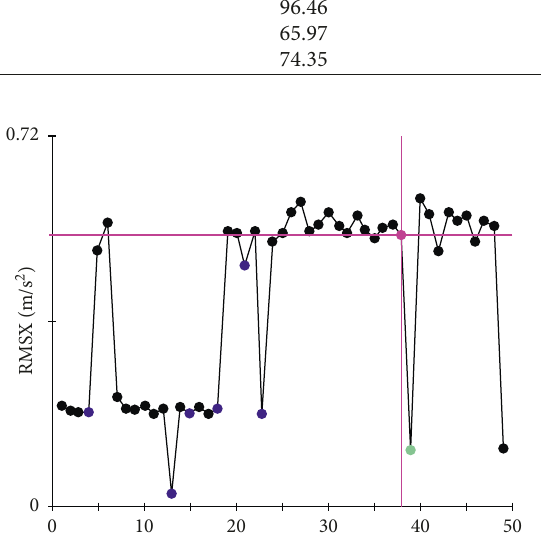
Figure 7: Iterative calendar of the RMS value optimization in the x direction of the steering